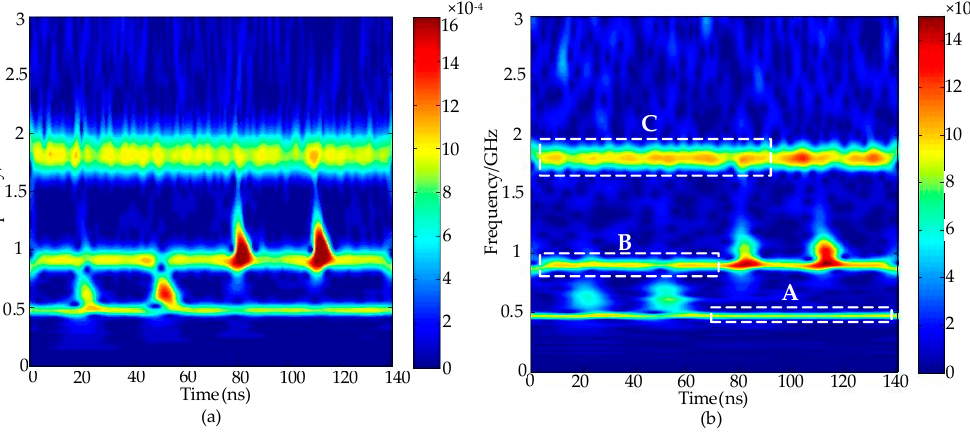
Figure 2. The time-frequency distribution of the noisy PD signals calculated by ( a ) the S-transform; and ( b ) the generalized S-transform.